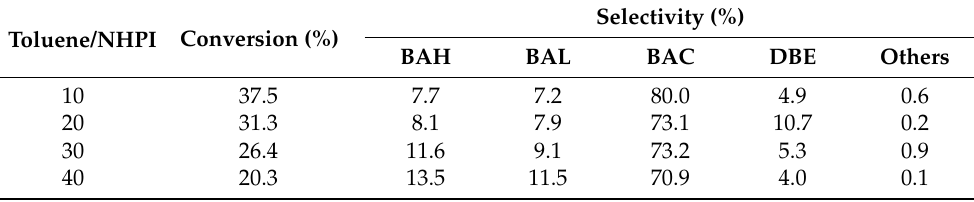
Table 4. Effect of toluene/NHPI on the catalytic oxidation of toluene by molecular oxygen a . Selectivity (%) Toluene/NHPI Conversion (%) BAH BAL BAC DBE Others 10 37.5